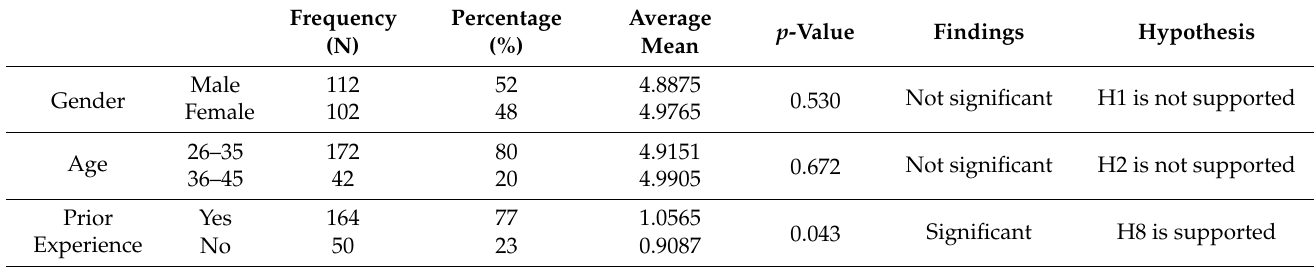
Table 1. The results of the independent sample T-test and average mean